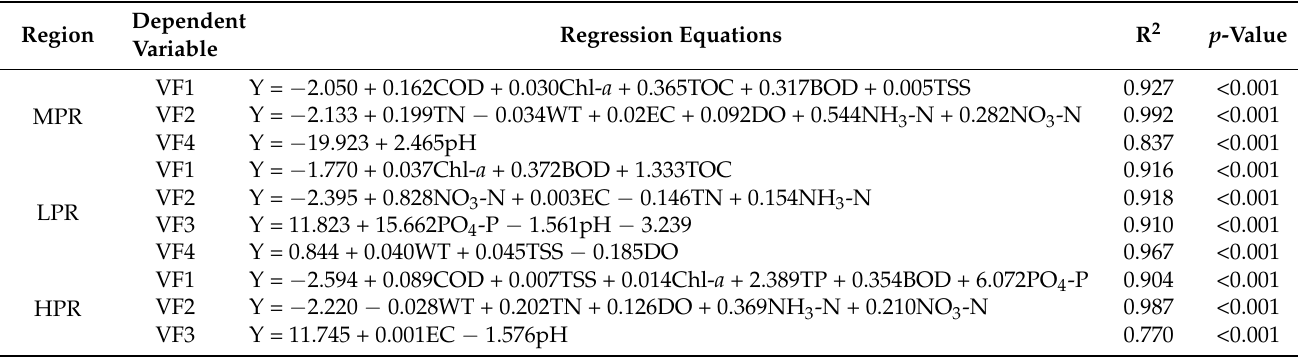
Regression Equations